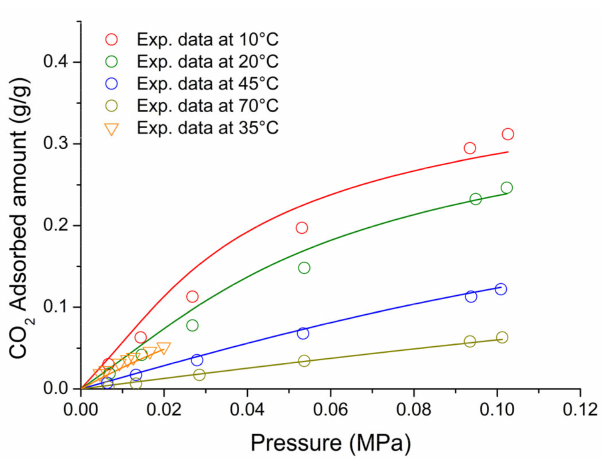
Figure 12. Comparison between RALF model prediction (solid lines) and experimental data of CO 2 adsorption isotherms at 10 ◦ C, 20 ◦ C, 45 ◦ C, 70 ◦ C (taken from [50]), and 35 ◦ C (taken from [137]).